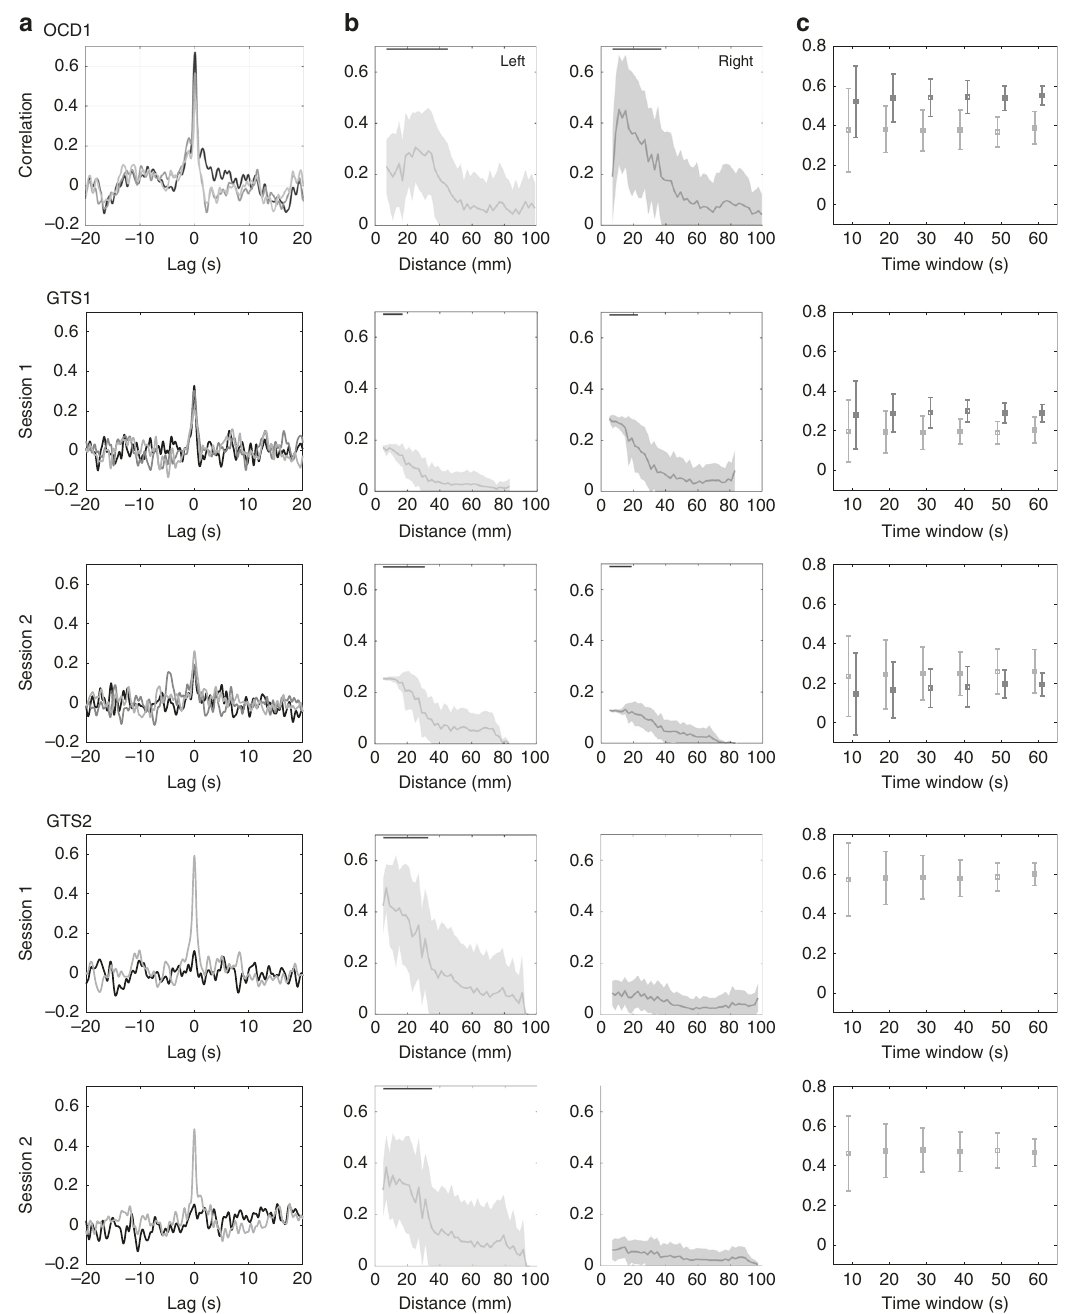
Fig. 3 Temporal and spatial properties of the correlation analyses. a Cross-correlation between source reconstructed and actual alpha envelopes recorded at intracranial electrodes, placed in the nucleus accumbens (OCD) and centromedial thalamus (GTS) of the left/right hemisphere displayed in light/dark gray respectively. The cross-correlation between intracranial electrodes in the two hemispheres is illustrated in black. Note the considerable peak at lag zero representing precise temporal alignment between the correlated signals in contrast to smaller values if this alignment is disrupted at larger lags. For GTS2 no signi fi cant correlation was found in subcortical regions of the right hemisphere, neither between intracranial recordings and source reconstructed signals, nor between intracranial recordings between the two hemispheres. b Correlation (mean ± SD) between source reconstructed and intracranial alpha envelopes as function of the distance to intracranial electrodes. Note that the maximum in these plots represents the localization error, while the steepness of the decay with increasing distance indicates the spatial resolution in these subcortical regions. Black lines on the top show signi fi cant ranges. c Correlation values (mean ± SD) computed from different window sizes showing the robustness of the results with respect to different time scales Spherical Model with Anatomical Constraints [LSMAC] 5,14,15 . Grey matter and inverse space. By taking the magnitude of this complex source space signal, this leads to alpha amplitude envelopes for each solution point. The 3D anatomical regions were identi fi ed using volumetric segmentation of individual T1- (xyz) information of each solution point was combined computing the weighted MRI (1 × 1× 1mm 3 ) scans, performed with the FreeSurfer image analysis norm. suite 28 – 30 . Source localization was applied using forward models based on realistic head The inverse solution space consisted out of about 5000 points equally geometry and conductivity data with consideration of skull thickness, i.e., Locally distributed in this gray matter volume. The linear distributed inverse solution NATURE COMMUNICATIONS| (2019) 10:753